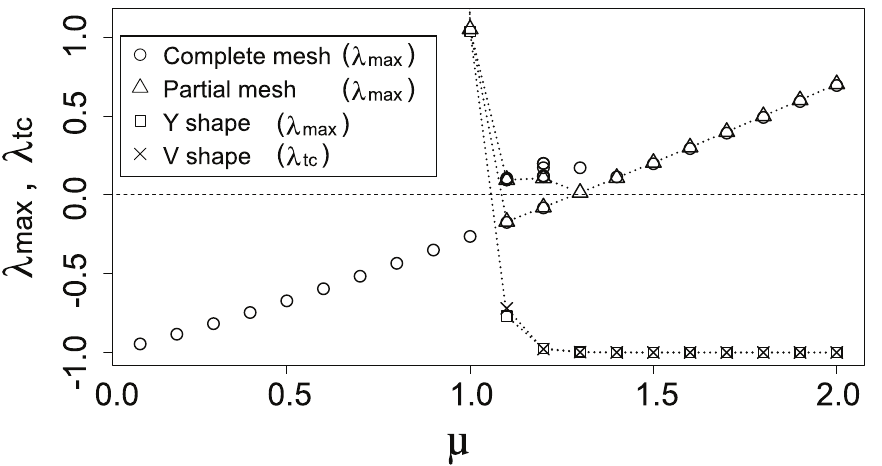
Figure 10. Maximum eigenvalues depending on when ~ 0 . Circles, triangles, and squares, respectively, denote l max at the equilibria of complete mesh (Fig. 8 A ), partial mesh (Fig. 8 E ), and Y-shaped (Fig. 8 G ). Crosses represent l tc for V-shaped (Fig. 8 H ) networks.